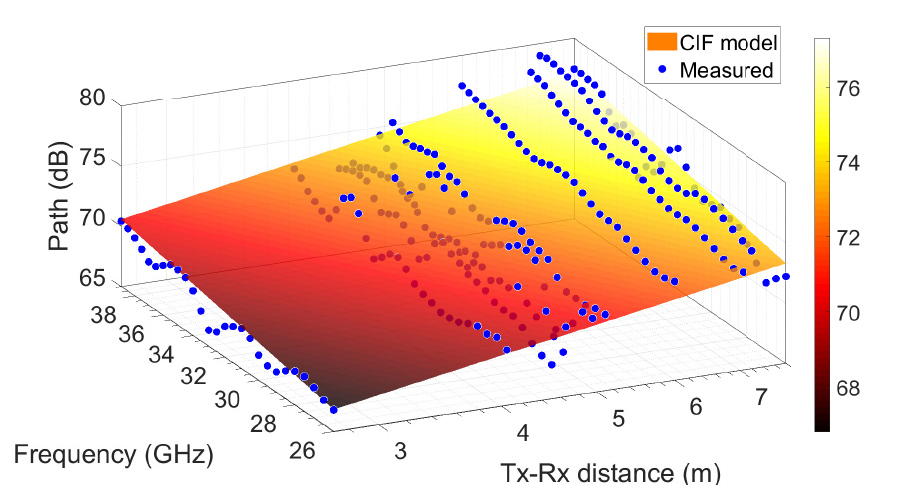
Figure 9. Measured and CIF path loss model in LOS conditions.